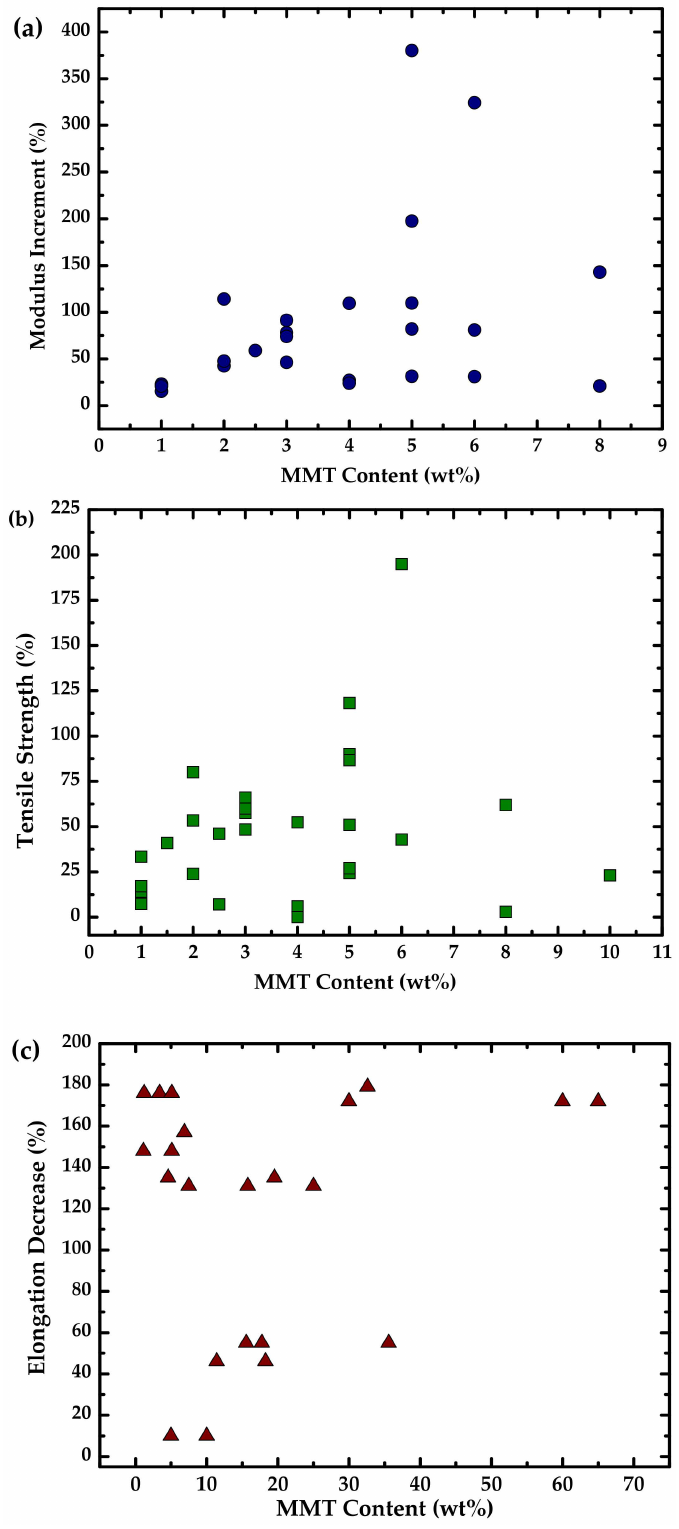
Figure 20. Mechanicalpropertieswithrespecttomontmorillonite(MMT)content: ( a )tensilestrength,( b ) modulus increment, and ( c ) elongation decrease. Prepared from data in